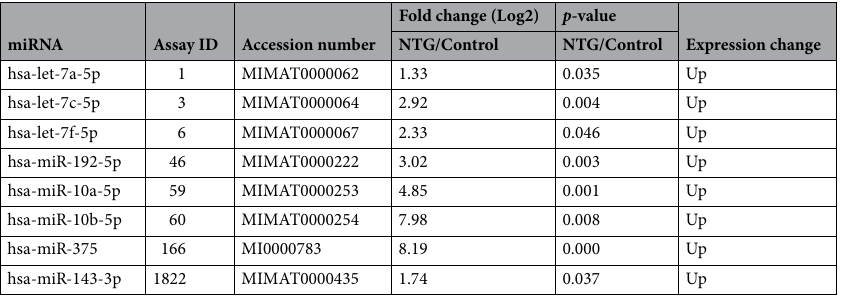
Table 2. Differentially expressed miRNA in the aqueous humor of normal tension glaucoma patients. NTG normal-tension glaucoma.